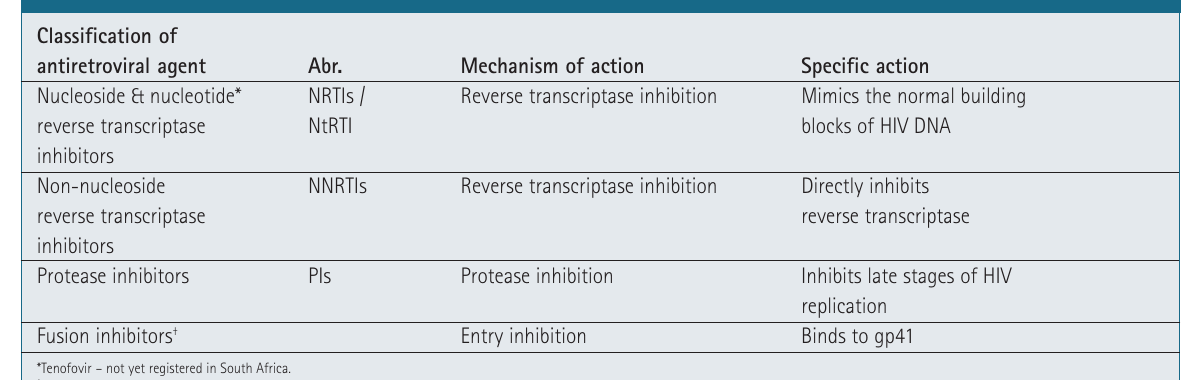
TABLE I. CLASSES OF ARV AGENTS AND THEIR MECHANISM OF